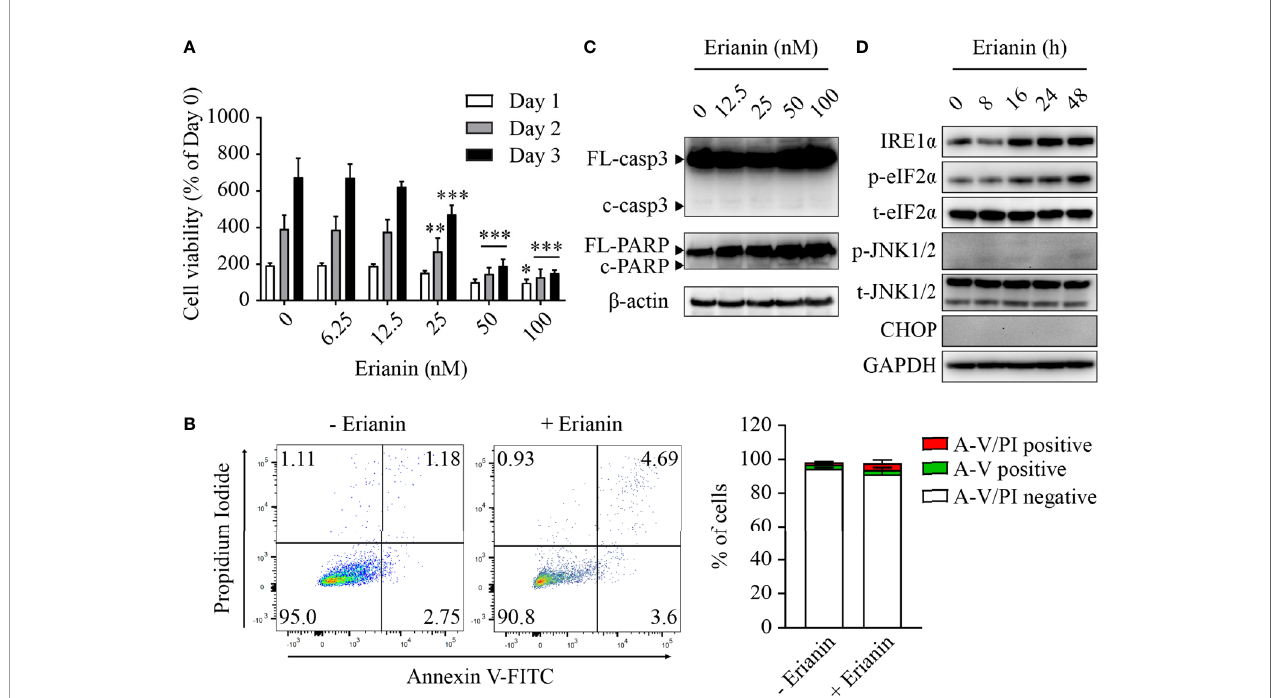
FIGURE 4 | Erianin fails to induce apoptosis in PC3 cells. (A) PC3 cell viability was determined by MTS colorimetric assay in cells treated with erianin at indicated concentrations for 1, 2 and 3 days. Data are shown as a percentage of untreated control at day 0. n=4. (B) Cells were treated with erianin at 100 nM for 24 h and apoptosis was analyzed by fl ow cytometry with propidium iodide (PI) and annexin V-FITC (A-V) co-staining. A-V single positive population represents early apoptotic cells, while A-V and PI double-positive population refers to late apoptotic/dead cells. n=3. (C, D) Cells were treated with erianin at indicated concentrations for 24 h (C) or at 100 nM for indicated times (D) . Apoptosis and ER stress were examined by Western blotting. FL-, full length; c-, cleaved; casp3, caspase 3. Data are expressed as mean ± SD. * p < 0.05; ** p < 0.01; *** p < 0.001, versus untreated